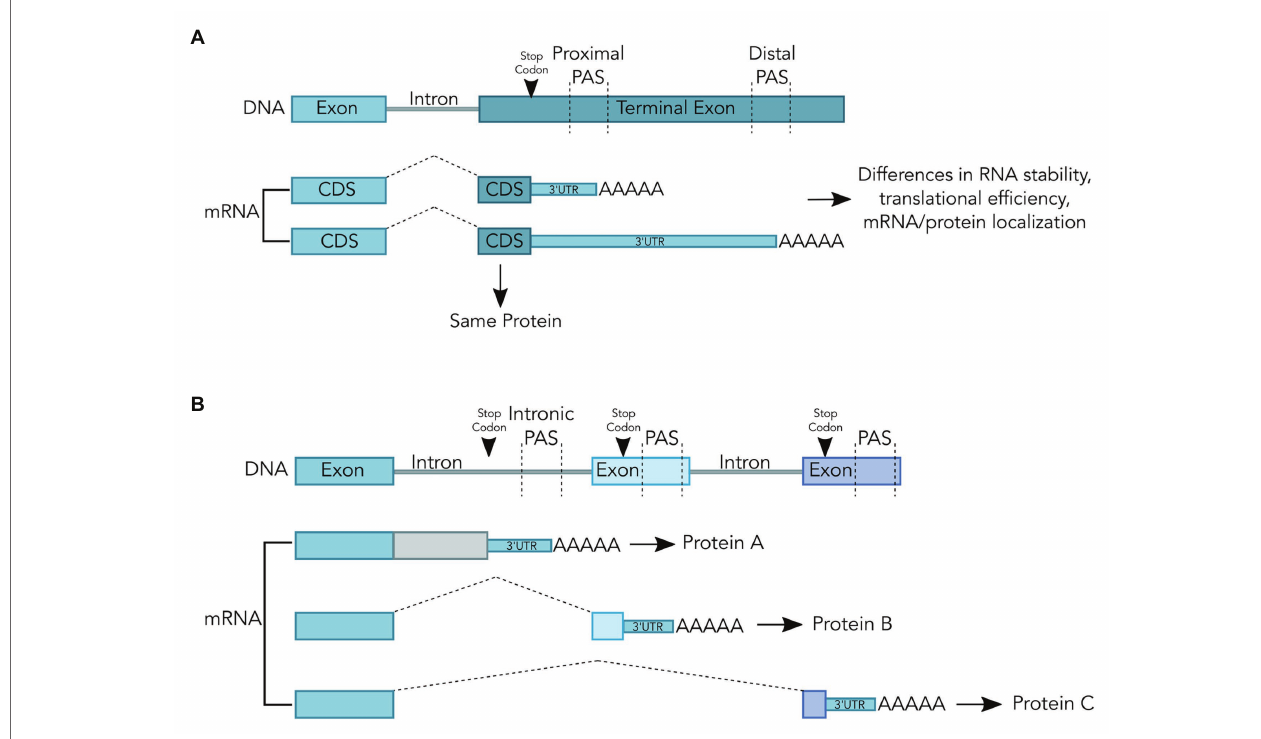
FIGURE 1 | Alternative Polyadenylation (APA) can, but does not always, change the coding sequence of the resulting mRNA transcript. (A) APA within the terminal exon does not change the coding sequence. The poly(A) tail is shown as AAAAA and splicing is shown as dashed lines. Selection of the proximal poly(A) site (PAS) or distal PAS results in the production of mRNA isoforms with different 3 ' untranslated regions (3 ' UTRs). These mRNAs may be subject to different regulation but code for identical proteins during translation. (B) Alternative polyadenylation (APA) upstream of the terminal exon changes the coding sequence. The poly(A) tail is shown as AAAAA and splicing is shown as dashed lines. In the first mRNA shown, selection of the intronic PAS results in an mRNA that will produce a truncated protein if translated. This truncated protein may not be functional, which can be used to repress gene expression. In the middle mRNA isoform, selection of an alternative PAS within an alternative exon results in exclusion of the downstream exon. As a result, this mRNA isoform has a different coding sequence than the final mRNA isoform, which could produce two proteins with alternative